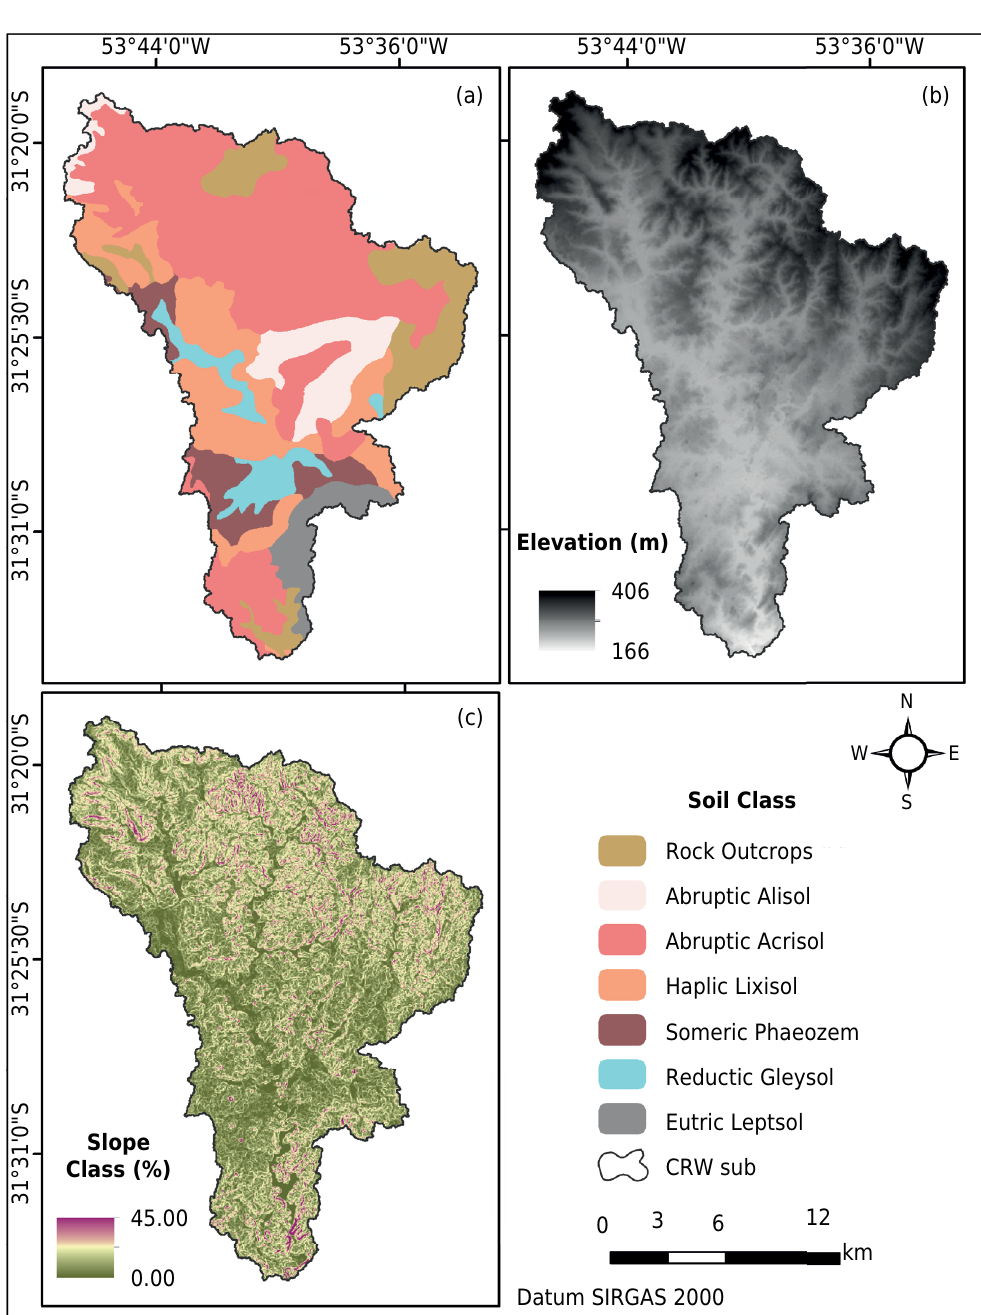
Figure 2. Indication of (a) digital elevation model; (b) slope and (c) soil classes in the Candiota river watershed (CRWsub). The soil classes were compared to the WRB classification